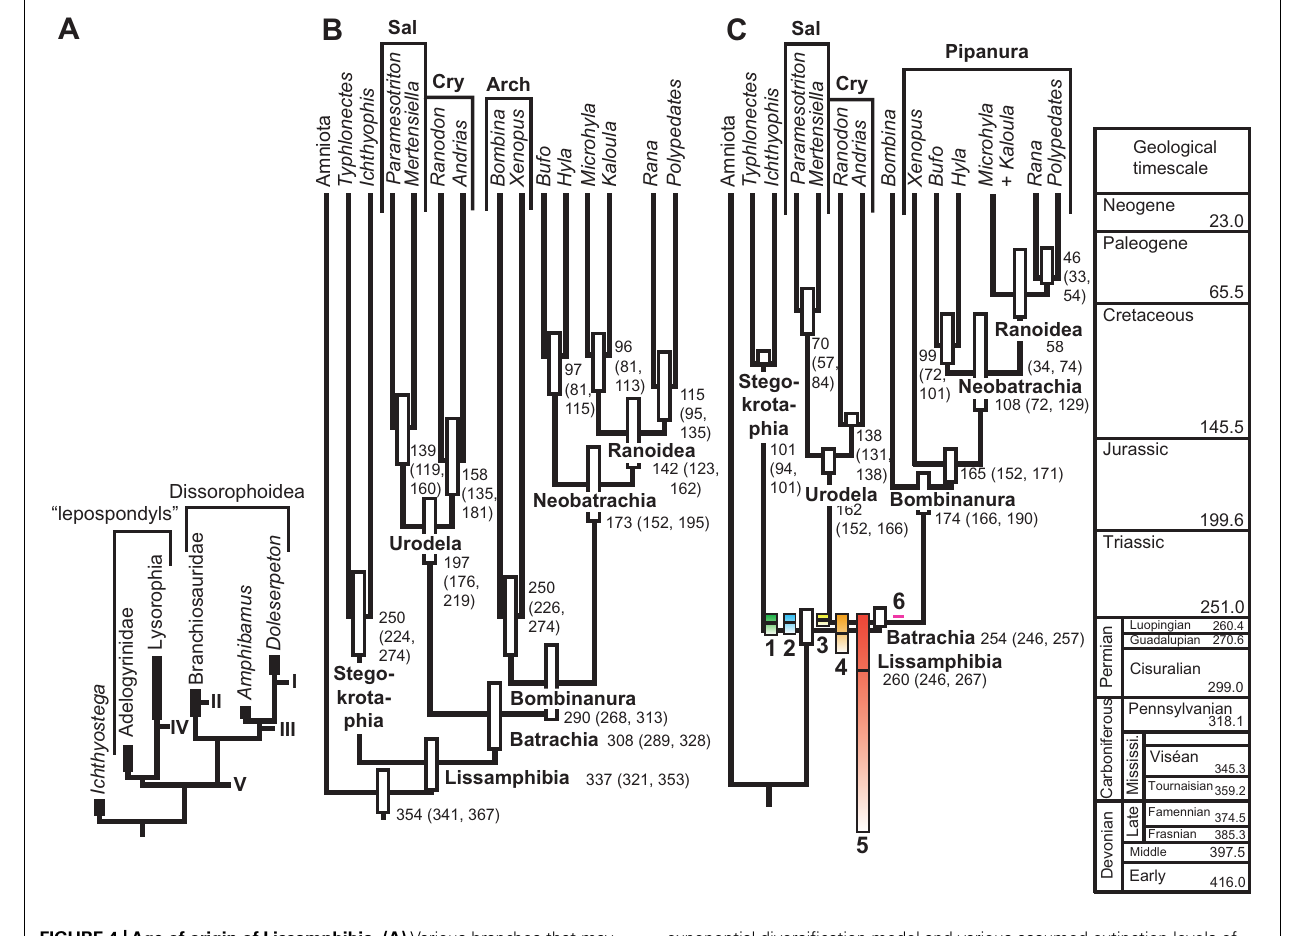
FIGURE 4 |Age of origin of Lissamphibia. (A) Various branches that may have given rise to the lissamphibian stem in the Paleozoic at points I through V. Under hypotheses of polyphyly, extant amphibians derive from both lepospondyls (at least for gymnophionans) and dissorophoid temnospondyls (anurans and, typically, urodeles). (B) Molecular ages of various lissamphibian clades proposed by Zhang etal. (2005). Bars represent 95% credibility intervals. (C) Colored bars: confidence intervals on the age of appearance of lissamphibians, given the stratigraphic distribution of fossiliferous localities that have yielded lissamphibians, and assuming an